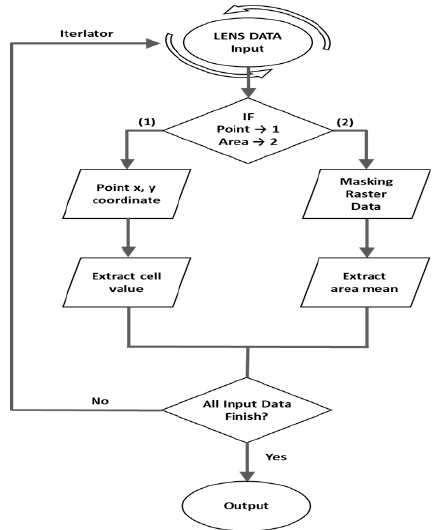
Figure 4. LENS analysis